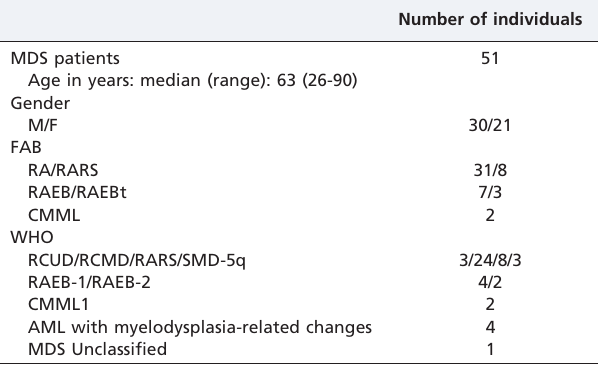
Table 1 - Patient characteristics.